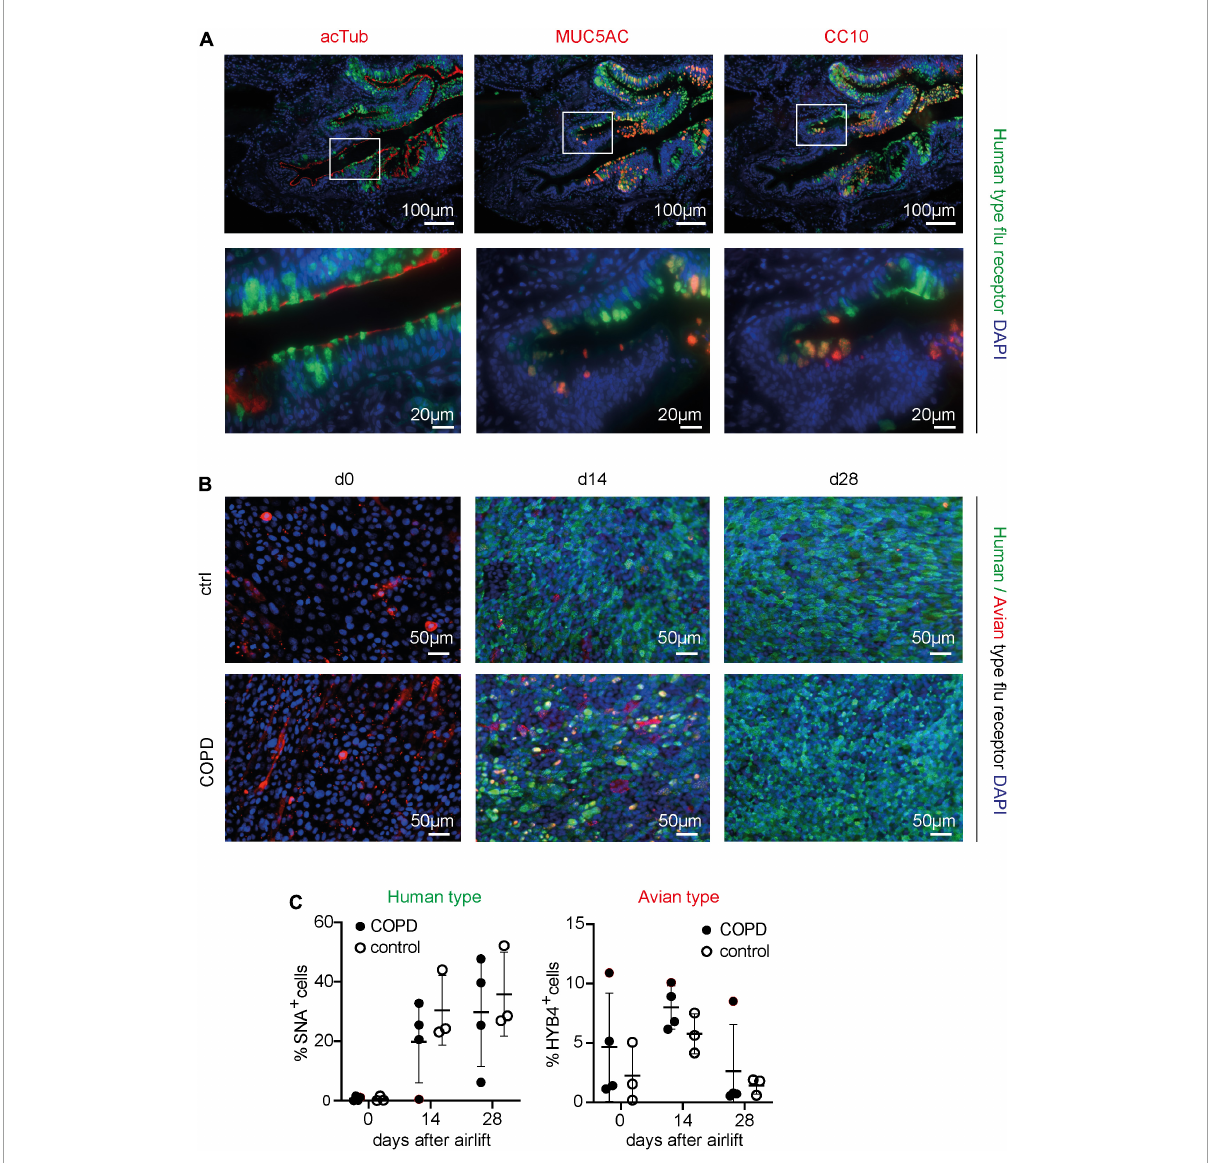
FIGURE1 Detection of the human- and avian-type flu receptors in lung sections and organotypic bronchoepithelium from patients with chronic obstructive pulmonary disease (COPD) and controls. Human lung sections (COPD n = 5, control n = 5) and primary human bronchial epithelial cells (phBECs) from patients with COPD ( n = 4) and controls ( n = 3) were stained with Sambucus Nigra lectin (SNA) that specifically binds to sialic acids bound to galactose by the α 2,6 linkage, SA α 2,6Gal, the human-type flu receptor, and a monoclonal antibody (clone HYB4) that specifically binds to SA α 2,3Gal, the avian-type flu receptor. (A) Detection of human-type flu receptor (green) in co-staining with antibodies directed toward acetylated tubulin (acTub), mucin 5AC (MUC5AC), or club cell-specific protein CC10 (red), for the identification of ciliated, goblet, or club cells, respectively, in formalin-fixed, paraffin-embedded human lung sections. The example shown is from a COPD lung explant. (B) Detection of human-type flu receptor (green) and avian-type flu receptor (red) in phBECs from COPD and control on days 0, 14, and 28 after airlift. (C) Quantification of the human- and avian-type flu receptors in phBECs on days 0, 14, and 28 after airlift. Panel (A) shows representative images for n = 5 (COPD) and n = 5 (control lung sections). Panel (B) shows representative images for n = 3 (control phBECs; here second control, see Table 1 ) and n = 4 (COPD phBECs; here GOLD stage III-derived phBECs); quantification of those data is given in panel (C) . For panel (C) , statistical analysis was performed using an unpaired, two-sided Mann–Whitney U test, but with a cutoff value of p < 0.05, no statistically significant differences were